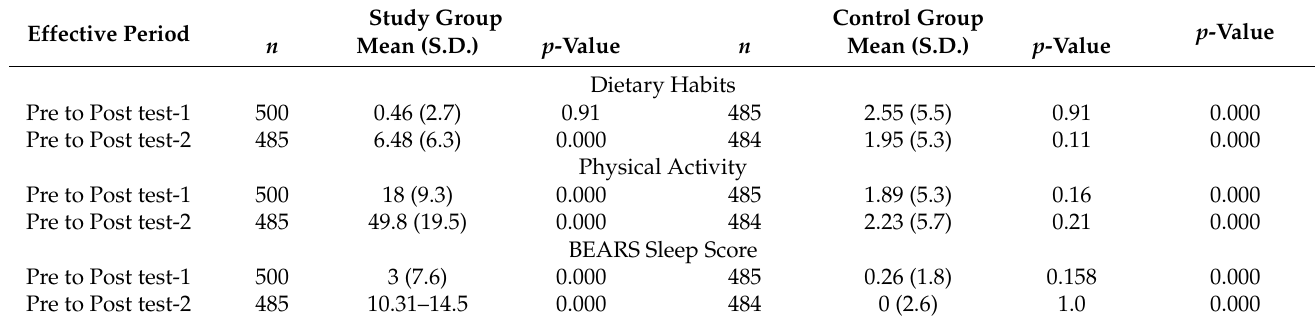
Table 3. Comparison of Effective score for Dietary Habits, Physical Activity, and Sleep.